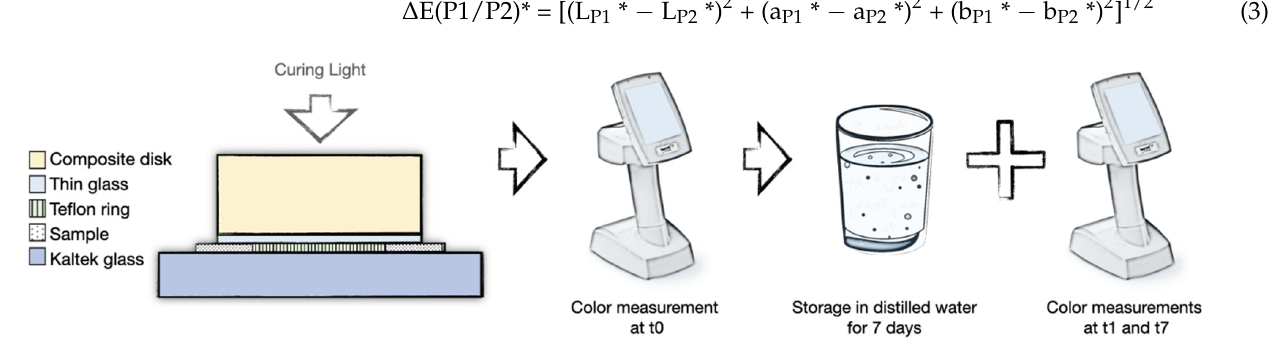
Figure 1. The methodological process followed in the study. Colour parameters were measured before (t0) and 1 day (t1) and 7 days (t7) after immersion of samples in distilled water.